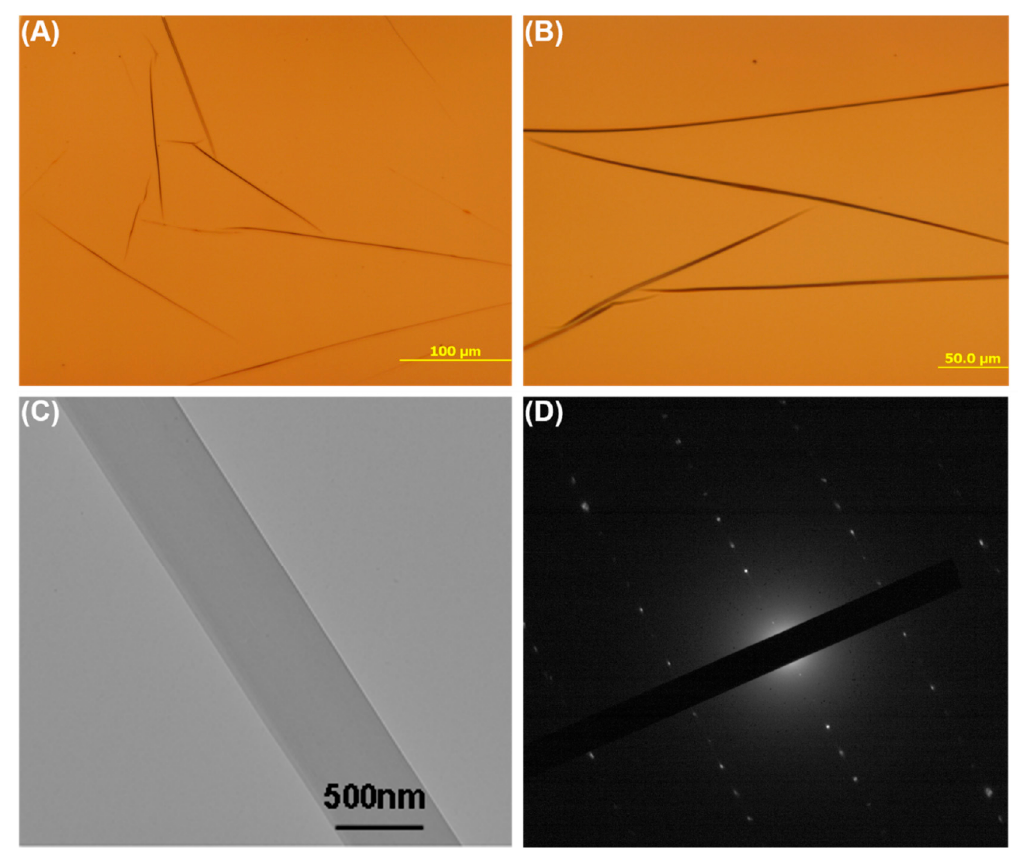
Figure 6. ( A , B ) PLM images of nanobelt-shaped single crystals of BPOSS-PDI-OH. ( C ) TEM image and ( D ) selected-area electron diffraction pattern of the nanobelt-shaped single crystals of BPOSS- PDI-OH.